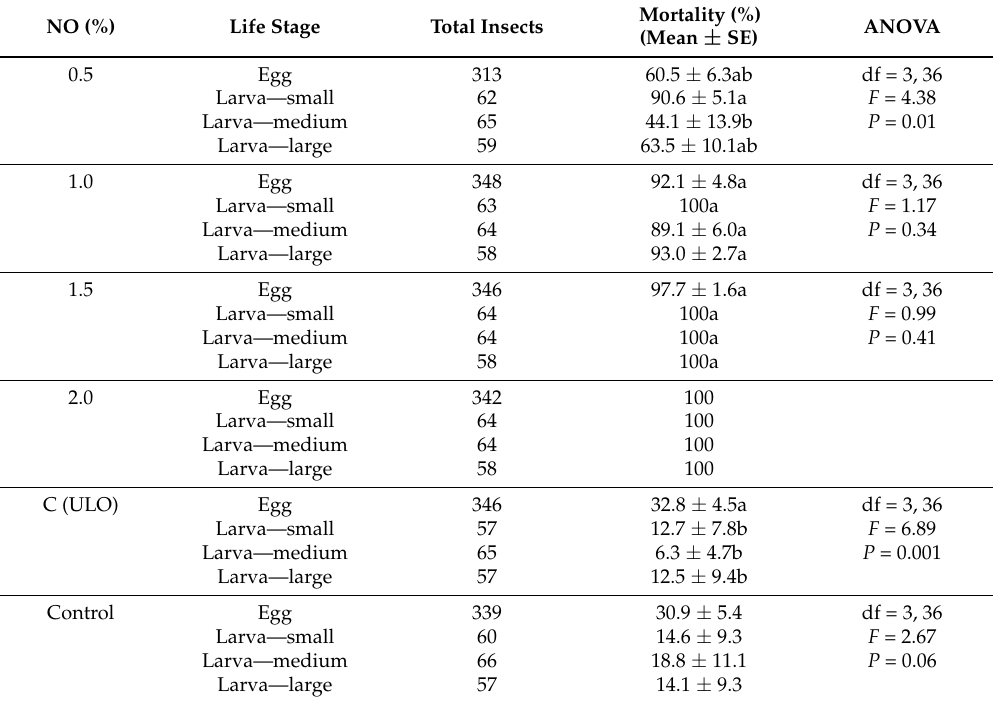
Table 1. Susceptibility of codling moth eggs and larvae of different sizes on artificial diet to 48 h nitric oxide fumigation treatments at 2 ◦ C.